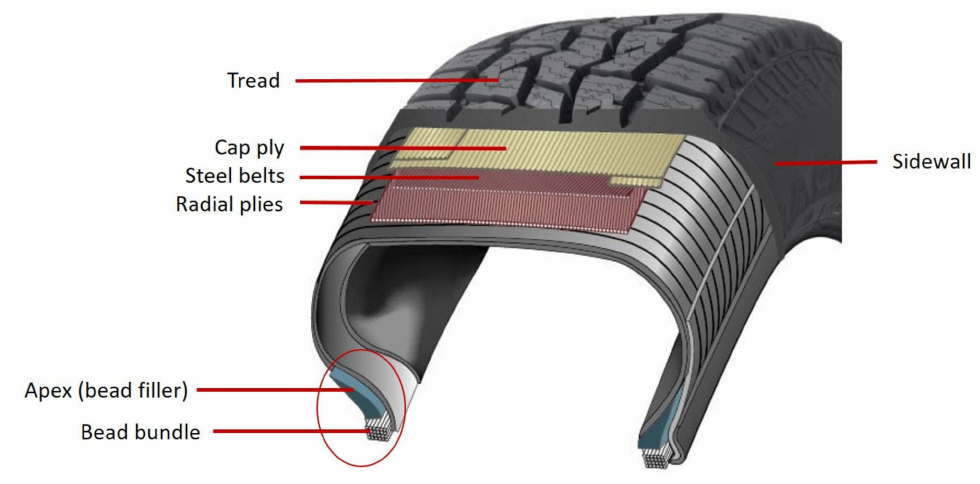
Figure 1. Composition of a